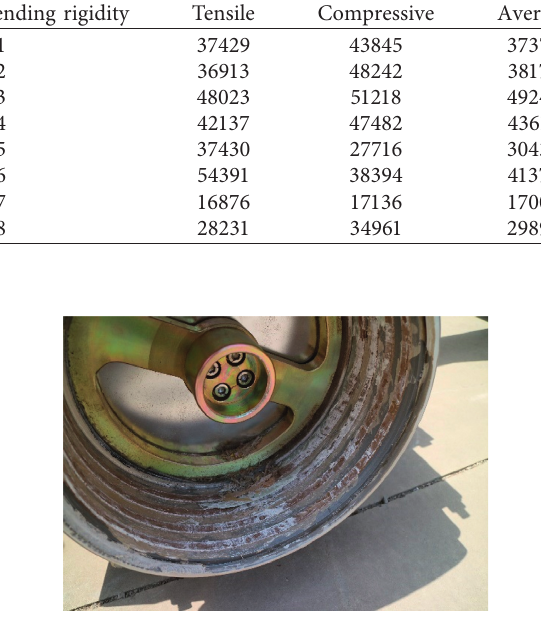
Figure 5: Cementing connection of the composite insulator flange.